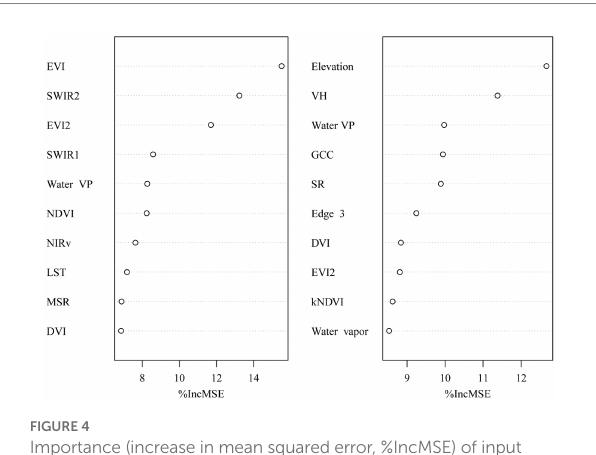
FIGURE 4 Importance (increase in mean squared error, %IncMSE) of input variables for random forest model in AGB estimation for grassland and shrubland.